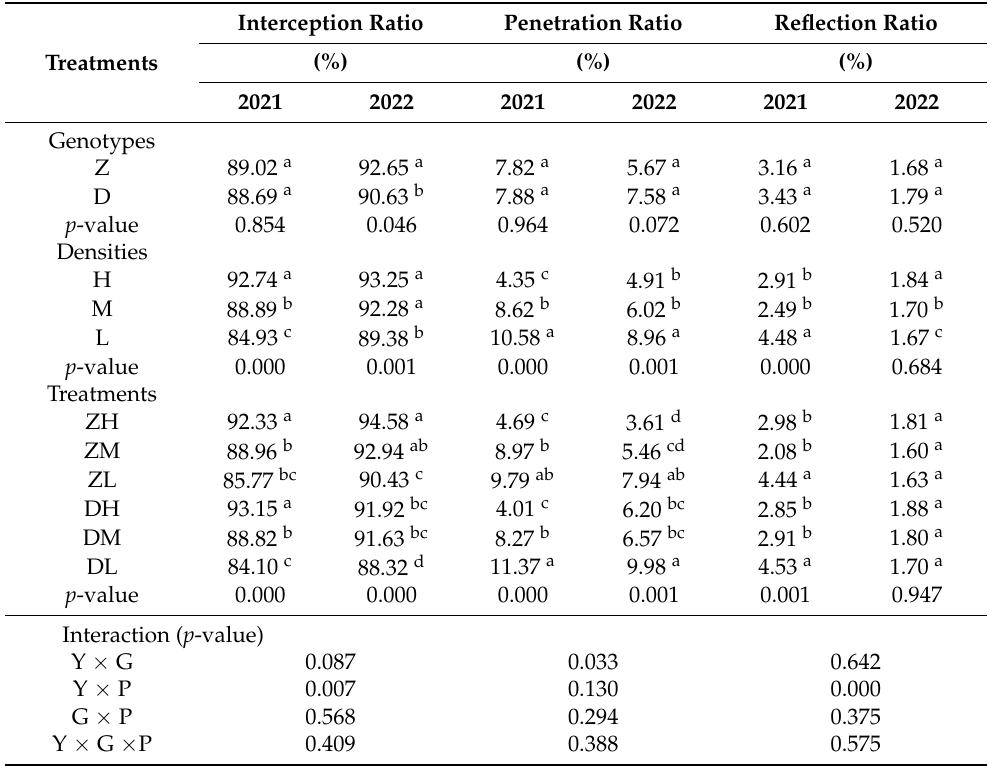
Table 1. Effects of planting densities and genotypes on canopy PAR interception ratio, penetration ratio, and reflection ratio during the summer maize R2 (filling stage) in 2021 and 2022.